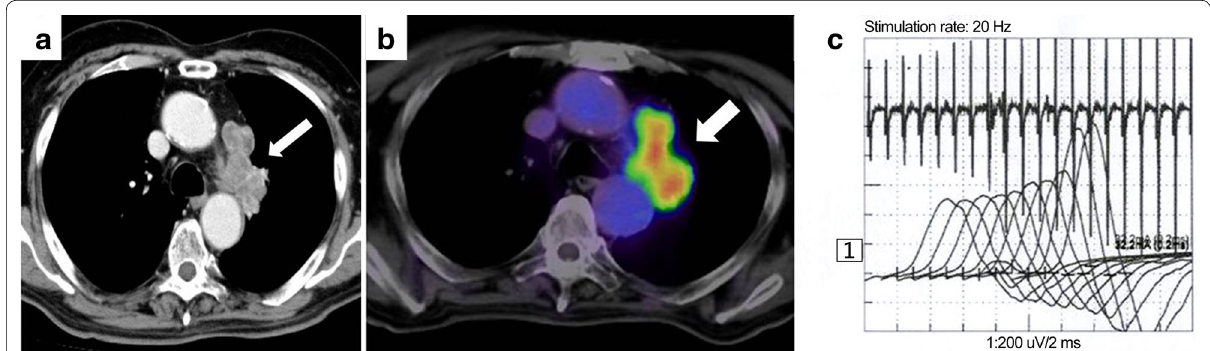
Fig. 3 Radiological findings and electromyography in the SCLC patient with LEMS at the age of 85 years. a Chest contrast CT revealed mediasti- nal and pulmonary hilar lymphadenopathy ( arrow ) on March 10, 2015. B, 2-deoxy-2-[18F]fluoro- d -glucose (FDG) positron emission tomography (PET)-CT showed FDG accumulation in the mediastinal and pulmonary hilar lymph nodes ( arrow ) on March 24, 2015. c Electromyography following stimulation at 20 Hz showed waxing on April 9,